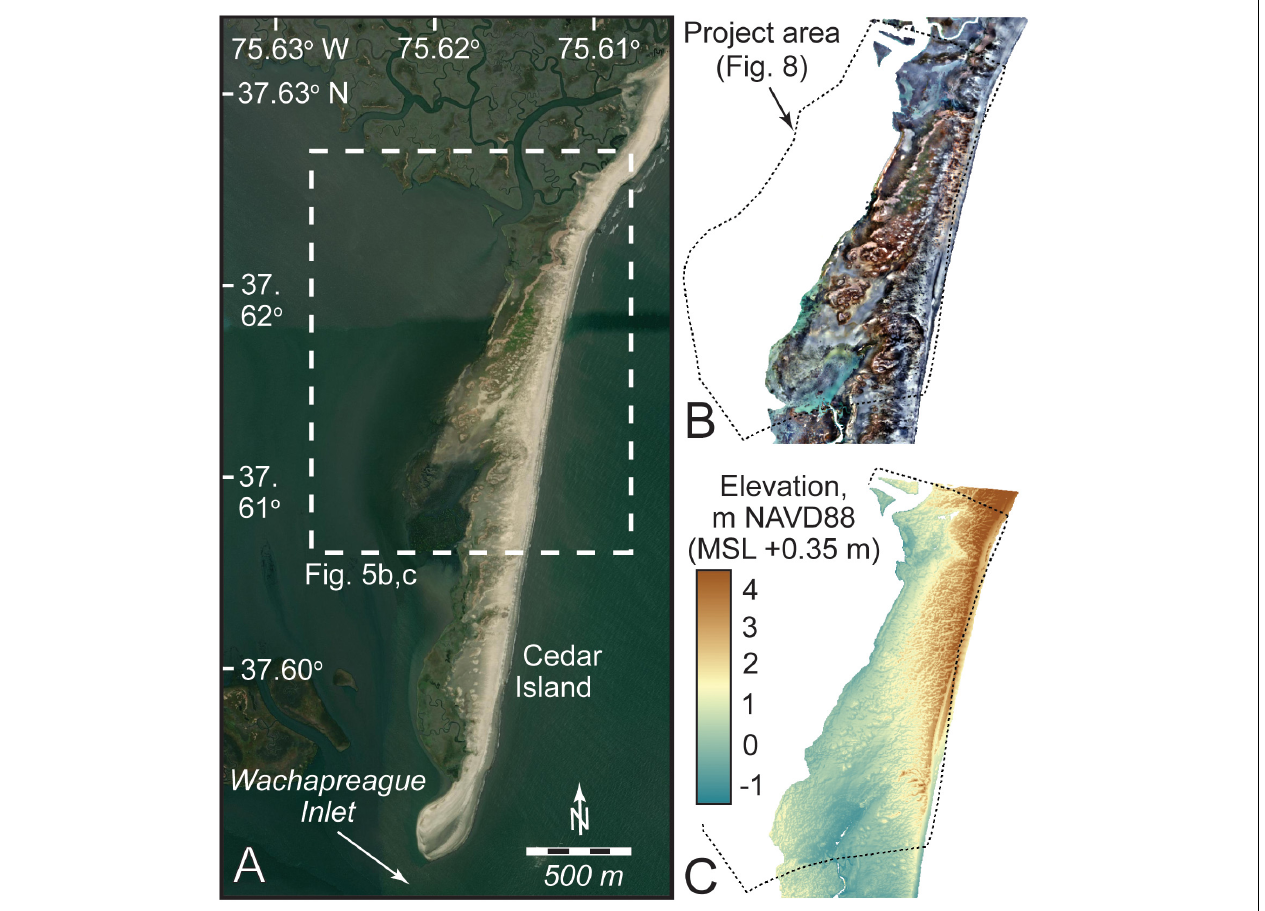
FIGURE 5 | Results of drone-based topographic-bathymetric mapping of the southern Cedar Island project area. (A) Satellite image of southern Cedar Island (December 2018; from National Agriculture Imagery Program, administered by the US Department of Agriculture’s Farm Service Agency). (B) Orthoimagery data collected and mosaicked through structure-from-motion technology, converted into (C) a digital elevation model. Data collected November 2019 and processed by K. McPherran, University of